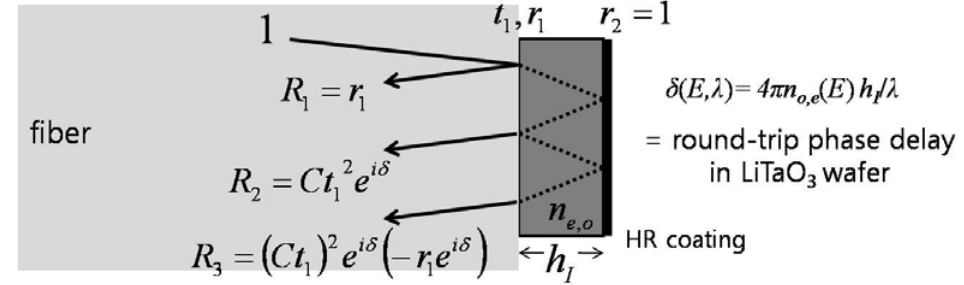
Figure 2. Reflected field components for type I EO probe. The r respectively, Fresnel reflection and transmission field coefficients at the front, or incident, and back interfaces. Ideally, r drawn with a non-normal incidence angle for ease in separating the transmitted and reflected beams, ( n : refractive index, λ : light